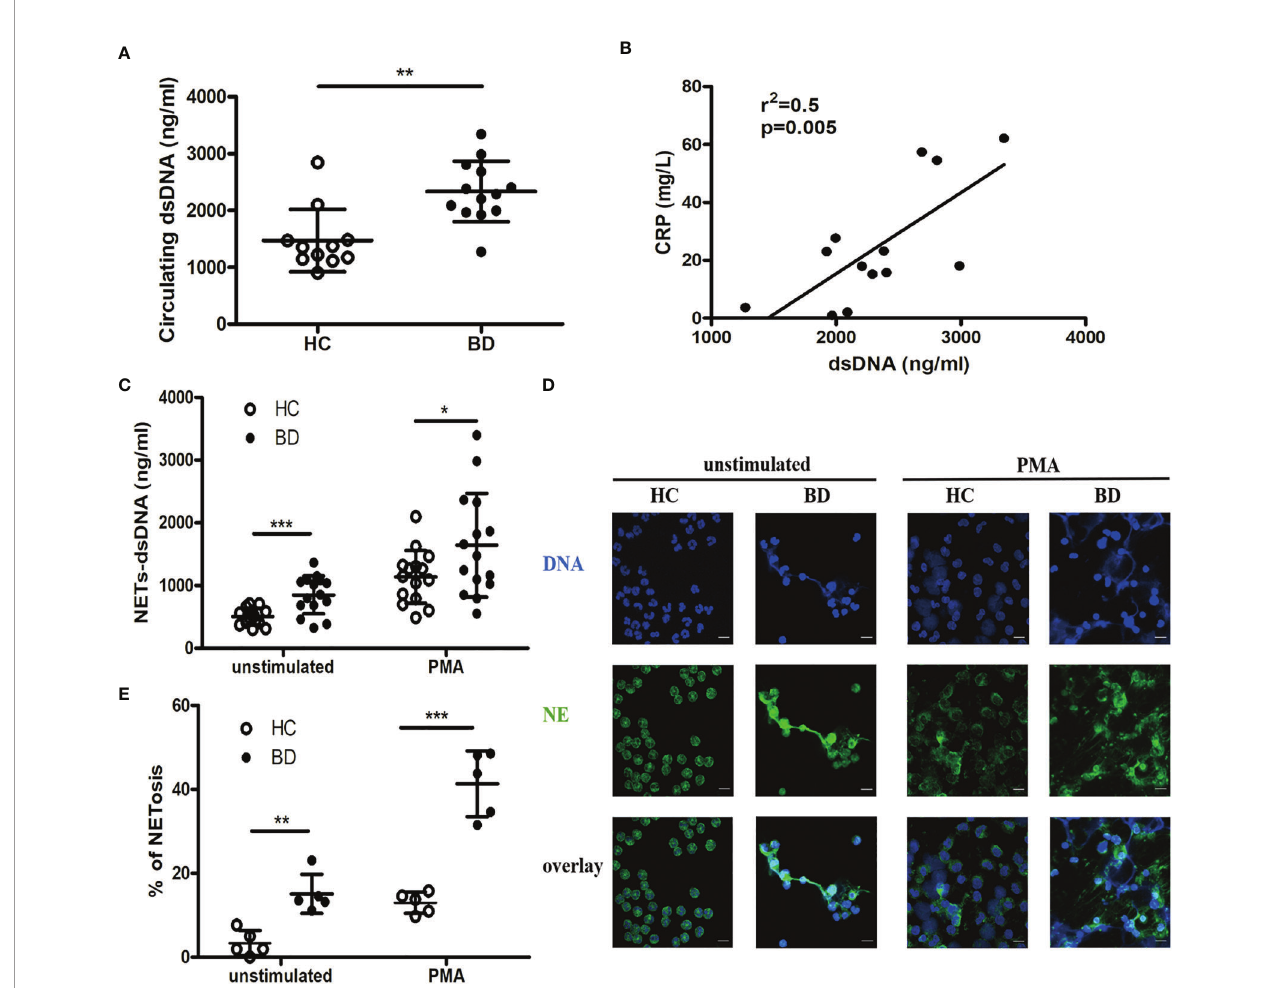
FIGURE 1 | BD neutrophils produce higher level of neutrophil extracellular traps (NETs). (A) Serum dsDNA from HC (n = 11) and BD (n = 13). (B) Correlation of serum dsDNA with CRP in BD (n = 13). (C) Unstimulated or PMA-stimulated HC (n = 15) and BD (n = 15) neutrophils were incubated for 4 h, and supernatant dsDNA was measured using PicoGreen. (D) Representative immuno fl uorescence staining of NETs produced by unstimulated or PMA-stimulated HC and BD neutrophils. Green and blue denote neutrophil elastase (NE) and DNA, respectively. magni fi cation 400×, zoom in×3, scale bars = 10 µm. (E) The proportion of NETosis induced in unstimulated and PMA-stimulated HC (n = 5) and BD (n = 5) neutrophils. Bars indicate mean value and Standard Deviation. Mann-Whitney U test (A) , Pearson correlation analysis (B) and Student ’ s t-test (C, E) were applied. *p < 0.05, **p < 0.01, ***p < 0.001. BD, Behc ̧ et ’ s disease; HC, healthy controls; ns, not signi fi